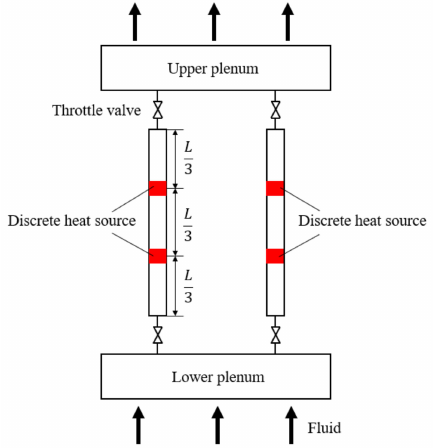
Figure 10. Uniform distribution of discrete heat sources.